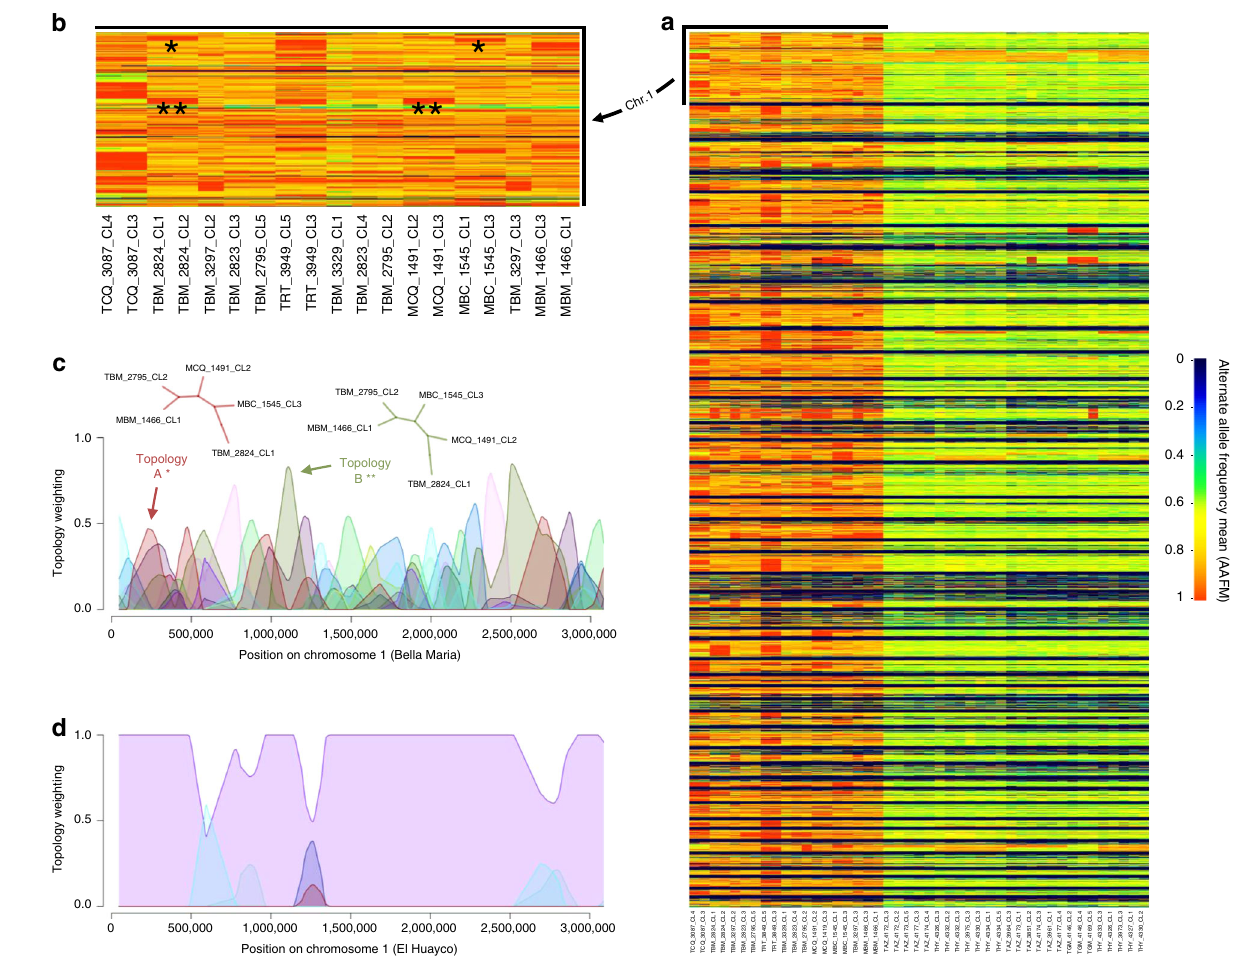
Fig. 4 Genome-wide heterozygosity patterns and intra-chromosomal mosaics in T. cruzi I clones. In a , each column represents the genome of one clone, considering the dataset ’ s total 130,996 SNPs. Rows within each column represent consecutive 5 kb sequence bins. Alternate allele frequency means (AAFM) determine the color of each bin – blue (0) through green (0.5) to red (1). Clones from Bella Maria tend to carry patchy homozygosity while those of Cluster 2 appear highly heterozygous throughout the genome. Isolated tracts of high homozygosity (i.e., red patches) shared between pairs of Bella Maria clones imply sudden sequence similarity and fl uctuating phylogenetic relationships inconsistent with divergence through drift. b provides a close-up on chromosome 1. c , d demonstrate the impact of this intra-chromosomal mosaicism on the topology of phylogenetic trees derived in a sliding window across chromosome 1. Multiple incongruent topologies are present in Bella Maria ( c ), consistent with widespread genetic exchange. Only a single topology dominates for samples of El Huayco d , consistent with limited genetic exchange in Cluster 2. An example of how AAFM heatmaps correspond to topology analyses is indicated in the heatmap close-up b and tree topologies in c : a shared red patch between TBM_2824_CL1 and MBC_1545_CL3 corresponds to neighbor-joining tree topology A in c . Later, near ca. 1100 kb, a shared patch of high AAFM between TBM_2824_CL1 and MCQ_1491_CL2 begins. This patch occurs where tree topology B best describes phylogenetic relationships in Bella Maria. Topology B is identical to topology A except for the replacement of MBC_1545_CL3 by MCQ_1491_CL2 as nearest neighbor to